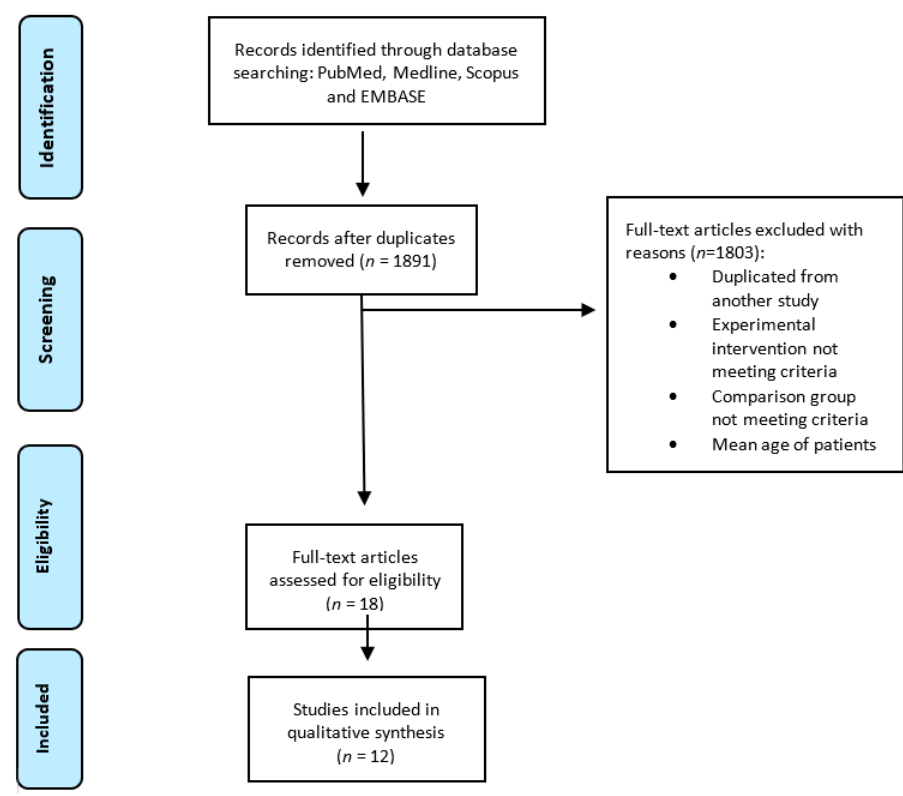
Figure 1. Preferred Reporting Items for Systematic reviews and Meta-Analyses (PRISMA) flow diagram.